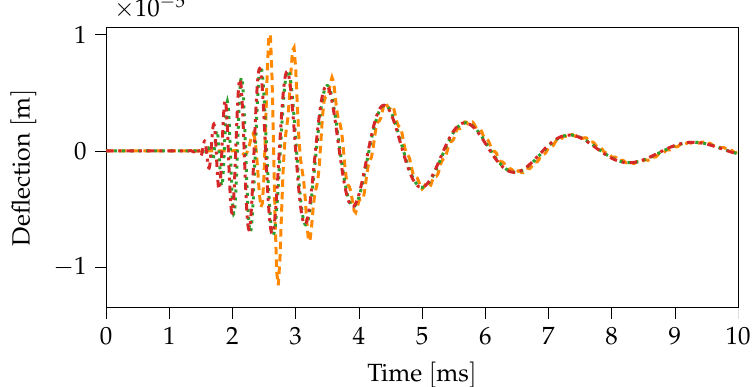
Figure 7. Deflection of a one-layer-supported beam at a distance of 10 m from the force point. ∆ t = 2.5 10 − 5 s ( ∆ x = 0.058 m, f max = 4 ·